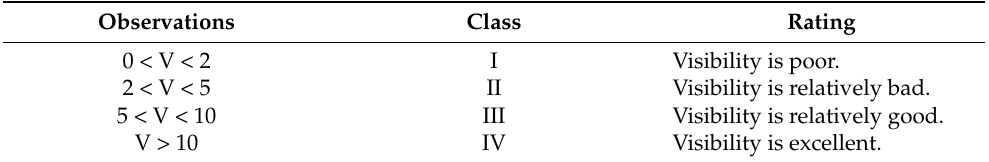
Table 4. Description of visibility classification.